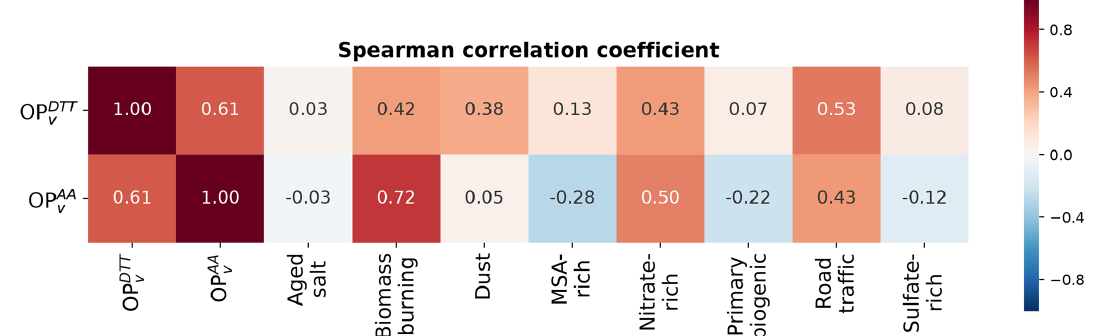
Figure A2. Spearman correlation coefficient between OP DTT v or OP AA v and the different PM sources identified for at least two-thirds of the sites. All the sites are merged, and whole time series of measurements were considered. The number of observations considered for the different sources are as follows: aged salt: 1430; biomass burning: 1700, dust: 1489, MSA-rich: 1595, nitrate-rich: 1700, primary biogenic: 1700, road traffic: 1587, sulfate-rich: